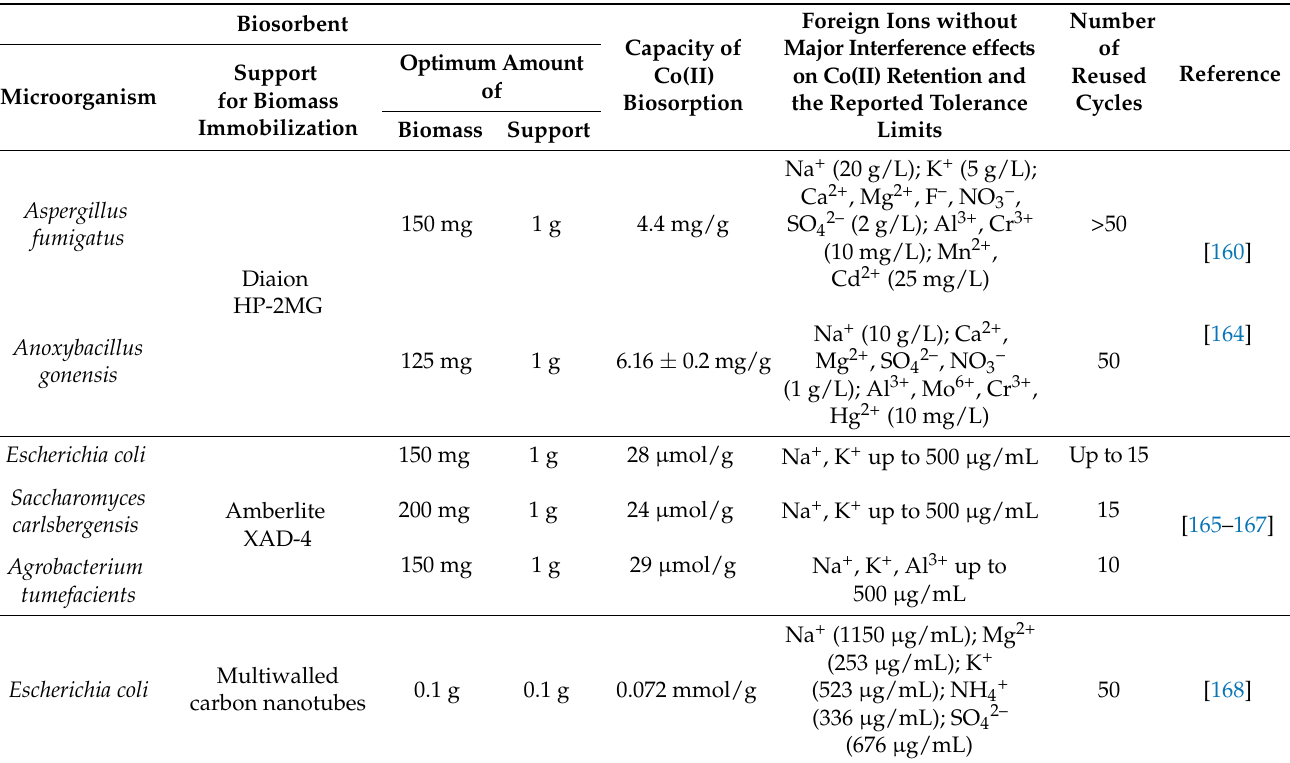
Table 5. Biosorbents based on immobilized microorganisms for analytical column preconcentration of Co(II) from model solutions of pH =